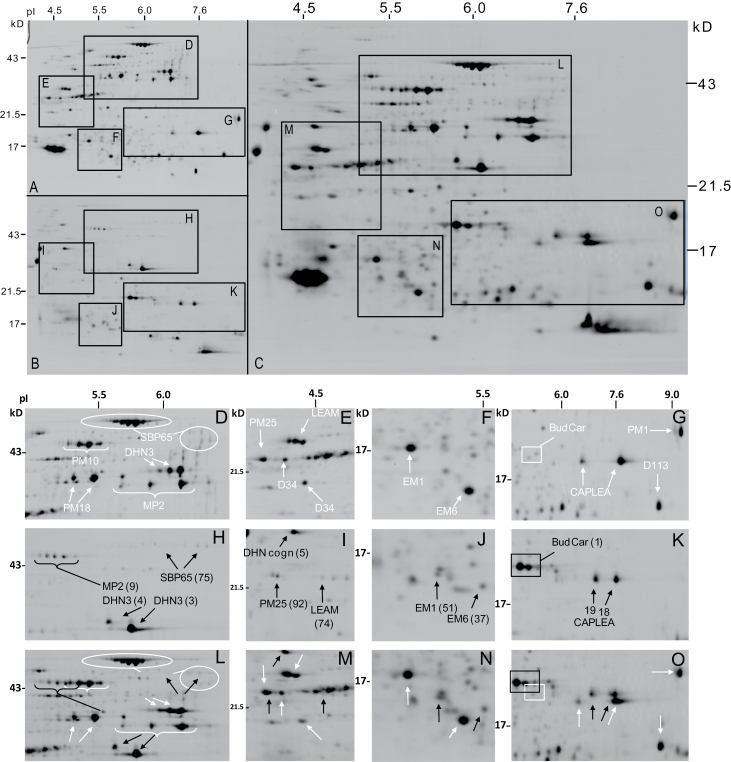
Comparative analysis of LEA polypeptides in the heat-stable proteome of cotyledons of Castanospermum australe and Medicago truncatula seeds. Reference map of the heat-stable proteome of M. truncatula (A) and C. australe seeds (B) and separation of a mixture of equal amounts of heat-stable proteins (150 μg) from both species (C). (D–O) Details of different regions of 2D gels of the proteome of M. truncatula (D–G), C. australe (H–K), and both species (L-O). The indicated spots refer to Supplementary Table S4 at JXB online.